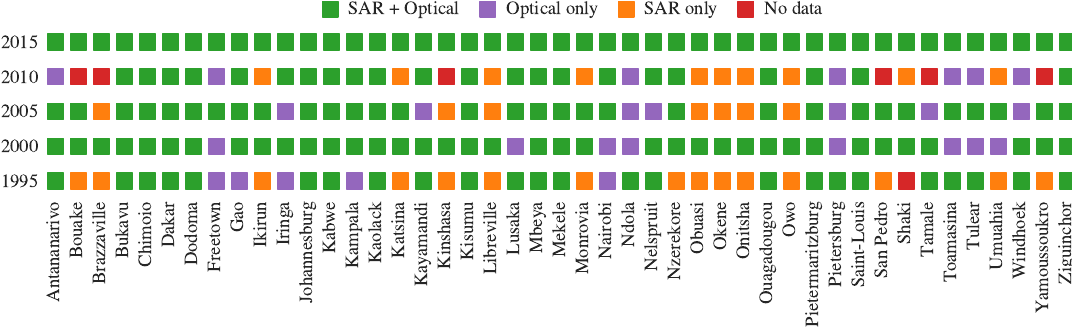
Figure 1. Availability of optical and Synthetic Aperture Radar (SAR) imagery for each case